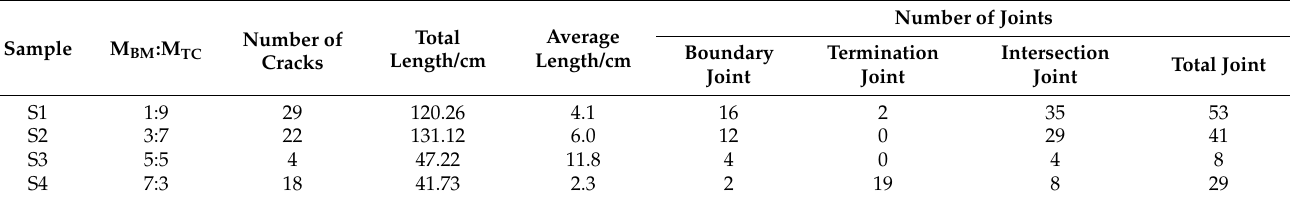
Table 4. Morphological parameters of samples with different values of M BM :M TC